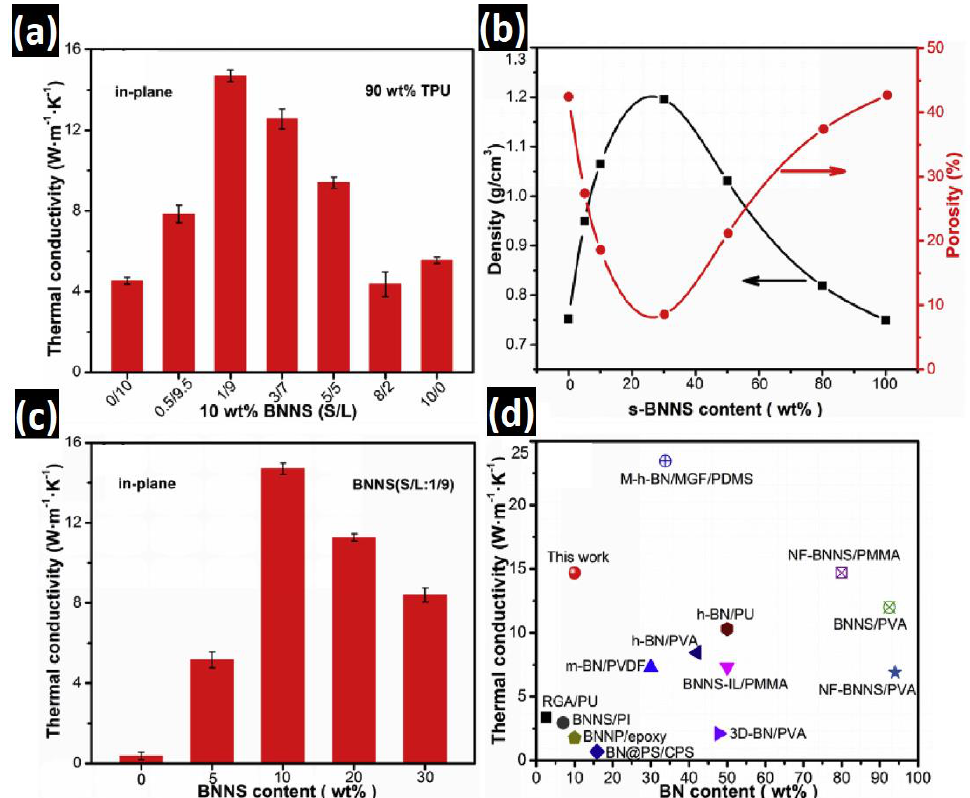
Figure 11. The S/L-BNNSs/TPU films with different S-BNNSs contents: ( a ) the in-plane TC, ( b ) density and porosity; ( c ) in-plane TC of the BNNSs/TPU films with different BNNSs contents; ( d ) comparison of the in-plane TC with h-BN fillers or TPU polymeric composites reported in previous studies (Reprinted with permission from Elsevier, Copyrights 2019) [59]. Table 1. Summary of recent PMCs reinforced with h-BN for enhancing thermal properties.